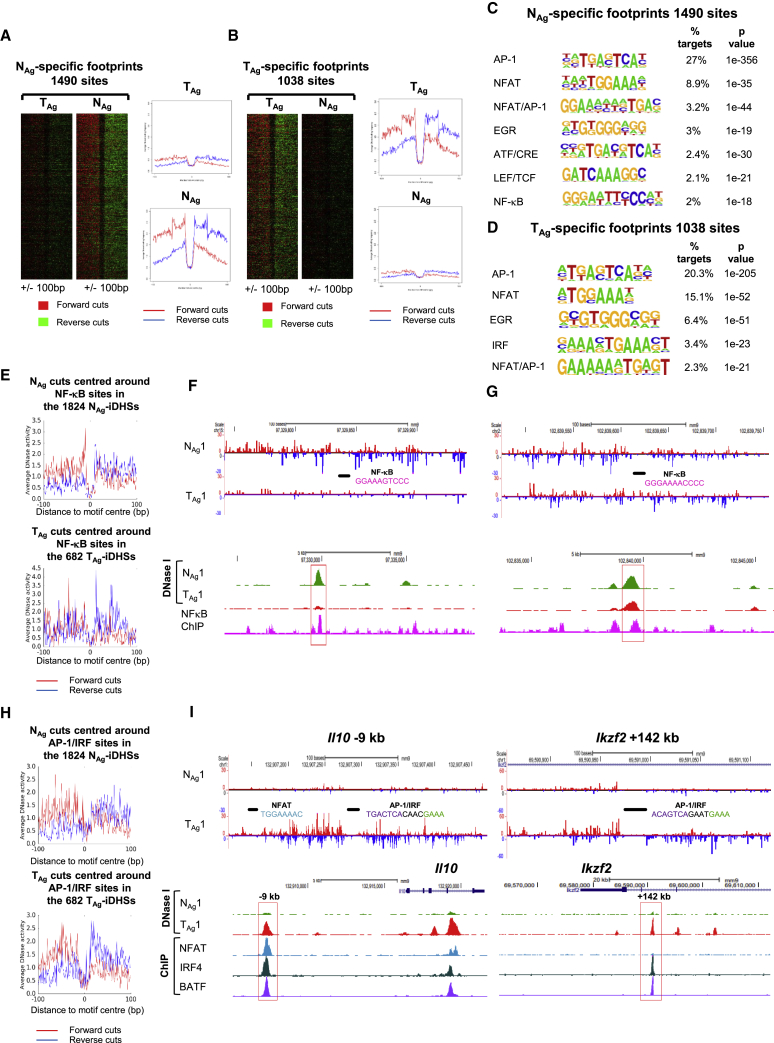
Footprinting Analyses of TF Occupation in Naive and Tolerized T Cells(A and B) Footprints within (A) NAg- and (B) TAg-specific iDHSs ordered according to the Wellington footprinting occupancy score.(C and D) HOMER de novo identification of TF motifs enriched within footprints in the 1,824 NAg-specific iDHSs (C) and the 682 TAg-specific iDHSs (D).(E) Average profile showing the DNase I cuts around all NF-κB sites in the 1,824 NAg-specific iDHSs in NAg (upper) and 682 TAg-specific iDHSs in TAg (lower).(F and G) Examples of Wellington digital footprinting of DNase-seq data showing protection of an NF-κB site at a NAg-specific iDHS (F) and at a shared iDHS (G). DNase-seq data are shown for NAg and TAg, and ChIP-seq data for NF-κB (Oh et al., 2017).(H) Average profile showing the DNase I cuts around all AP-1/IRF sites in the 1,824 NAg-specific iDHSs in NAg (upper) and 682 TAg-specific iDHSs in TAg (lower).(I) Examples of Wellington digital footprinting of DNase-seq data showing protection of NFAT and composite AP-1/IRF motifs. DNase-seq data are shown for NAg and TAg, and ChIP-seq data for NFAT1 (Martinez et al., 2015), IRF4, and BATF (Li et al., 2012).